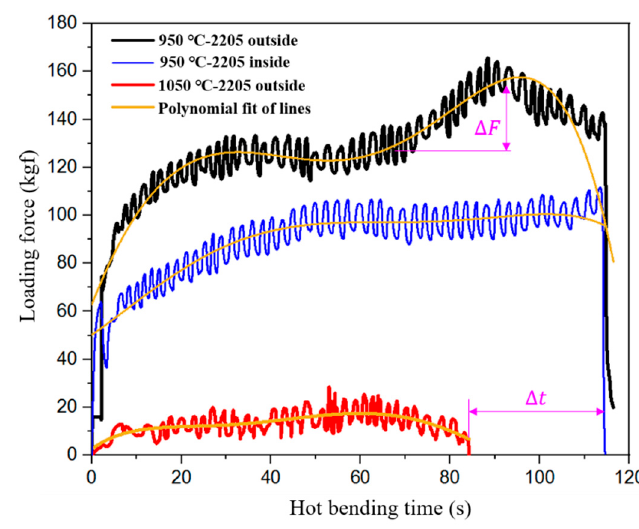
Figure 12. The loading force of specimens under different forming conditions.